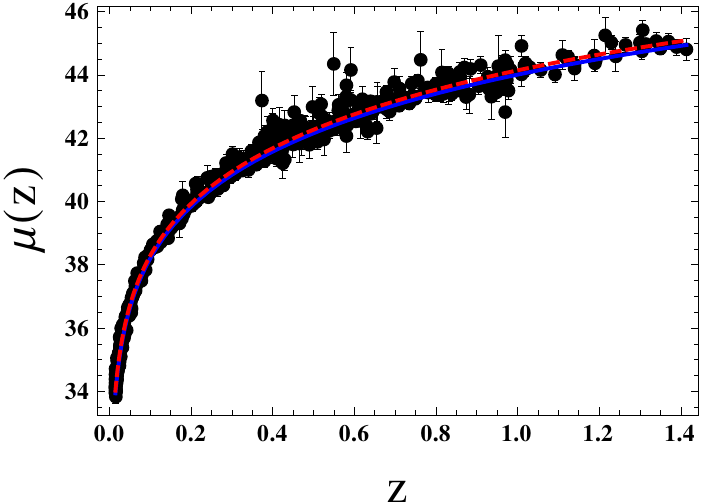
Figure 1. The evolution of the Hubble parameter (blue curve) is shown for the best-fit values of model parameters, as given in Table 1, arising from the joint analysis of H ( z ) + BAO + CMB + BBN + SNIa (Pantheon) dataset ( left panel) and H ( z ) + BAO + CMB + BBN + SNIa (Union 2.1) dataset ( right panel). Here, the red curve represents the corresponding evolution of H ( z ) in a standard Λ CDM model with Ω cdm 0 = 0.315, H 0 = 67.4 km/s/Mpc [40] ( left panel) and Ω cdm 0 = 0.2675, H 0 = 71.3 km/s/Mpc [37] ( right panel). In this plot, the green dots correspond to the 51 H ( z ) data points in the redshift range 0.07 ≤ z ≤ 2.36, obtained from different surveys and the corresponding H ( z ) values are given in [44]. In the inset diagram, the corresponding relative difference, ∆ H ( % ) = 100 × ( H NGCG ( z ) − H Λ CDM ( z )) / H Λ CDM ( z ) , is shown for the best-fit model.